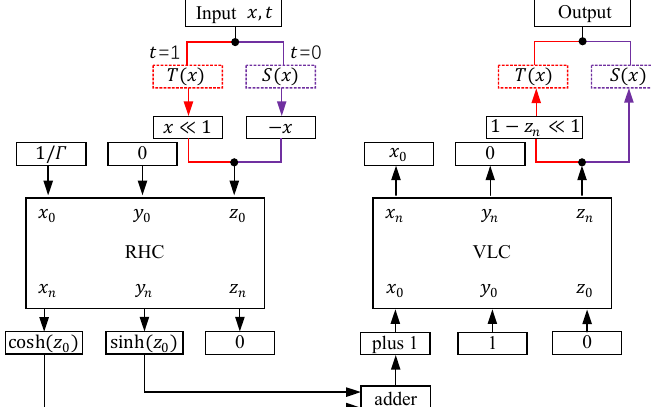
Figure 1. The architecture of computing S ( x ) and T ( x ) based on RHC and VLC. The red path is for computing T ( x ) , the purple path is for computing S ( x ) , and the black path is